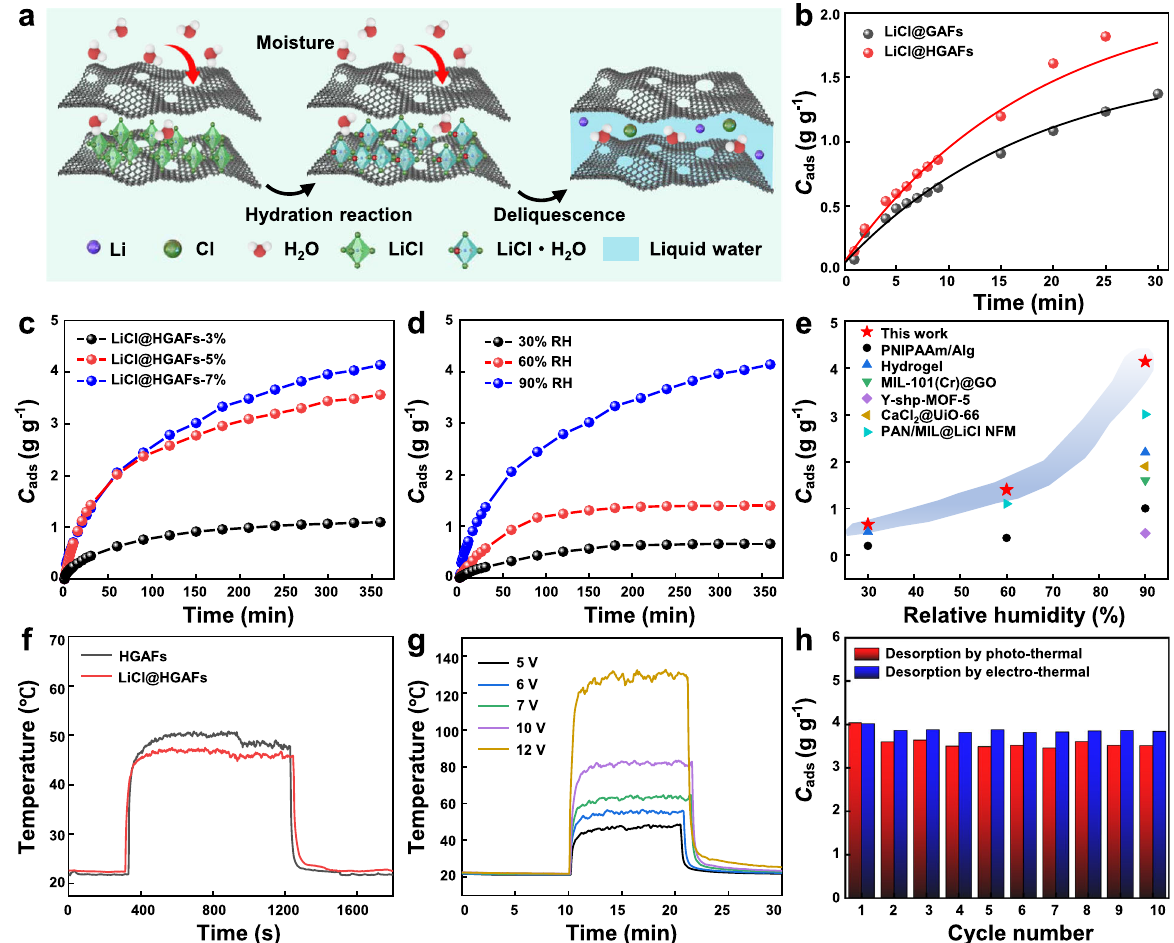
Fig. 3 High ef fi cient moisture capture by LiCl@HGAFs. a Schematic illustration of the moisture sorption process. In this process, LiCl reacts with water fi rst to form LiCl·H 2 O, and then deliquesce to form LiCl solution, and the captured moisture exists in the form of liquid water (blue-shaded region). b Water uptake of LiCl@GAFs and LiCl@HGAFs at 25 °C and 90% RH in 30 min. Source data are provided as a Source Data fi le. c Water uptake of LiCl@HGAFs with different salt contents at 25 °C and 90% RH. Source data are provided as a Source Data fi le. d Water uptake of LiCl@HGAFs under the relative humidity of 30%, 60%, and 90%. Source data are provided as a Source Data fi le. e Comparison of water sorption capacity with reported